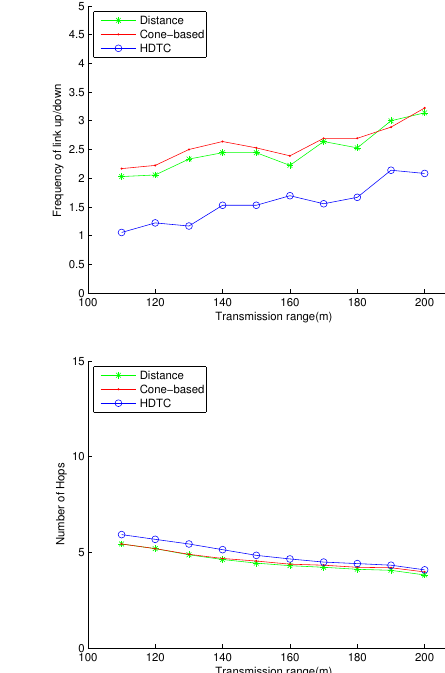
Figure 17. Scenario 3: The connection time, the frequency of the link up/down, the group size and the number of hops with varying the connection